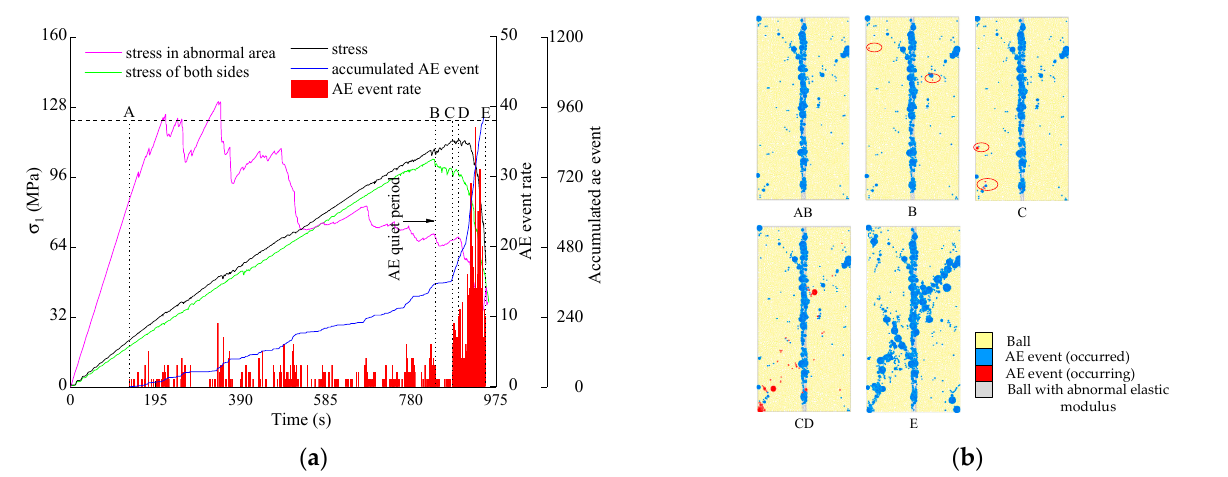
Figure 7. Numerical simulation results. ( a ) Stress and AE events of specimens with abnormal elastic modulus of 80 GPa; ( b ) AE events distribution at different stages of the specimen.